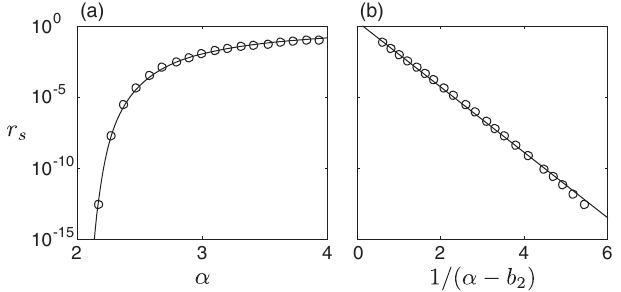
FIG. 7. Length r s of the simple boundary segment on the line y ¼ 0 for systems with potential U α . (a) The circles indicate the numerically estimated r s as a function of α . The solid curve is the best nonlinear fit to the data, as described in Appendix C. (b) The same quantities shown as a function of 1 = ð α − b 2 Þ , with the best-fit value of b 2 ≈ 1 . 986